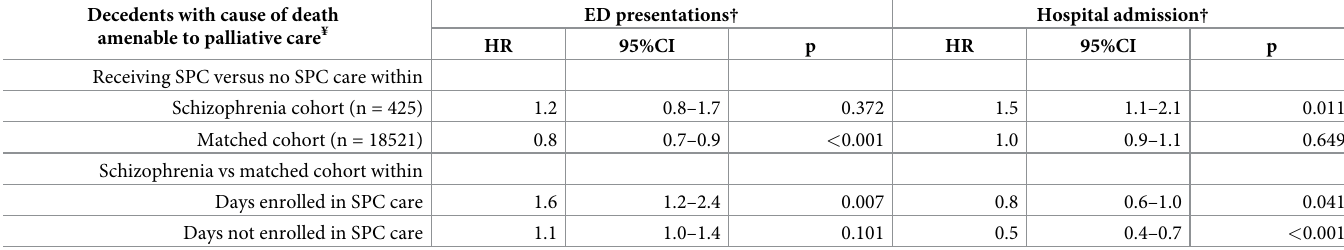
Table 7. Association of community-based specialist palliative care with rates of ED presentations and hospital admissions for the schizophrenia and matched cohorts amongst the subset of decedents who died from conditions amenable to palliative care (n = 18,946). Decedents with cause of death amenable to palliative care